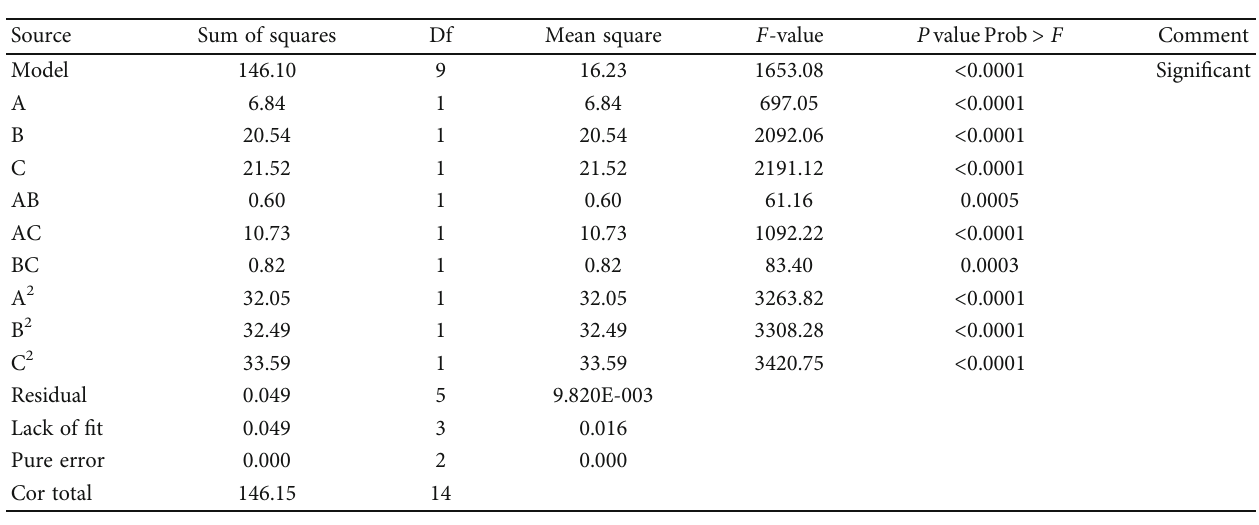
Table 2: ANOVA for the surface response model of Cr (VI) removal e ffi ciency: (a) ATB and (b) BTB.